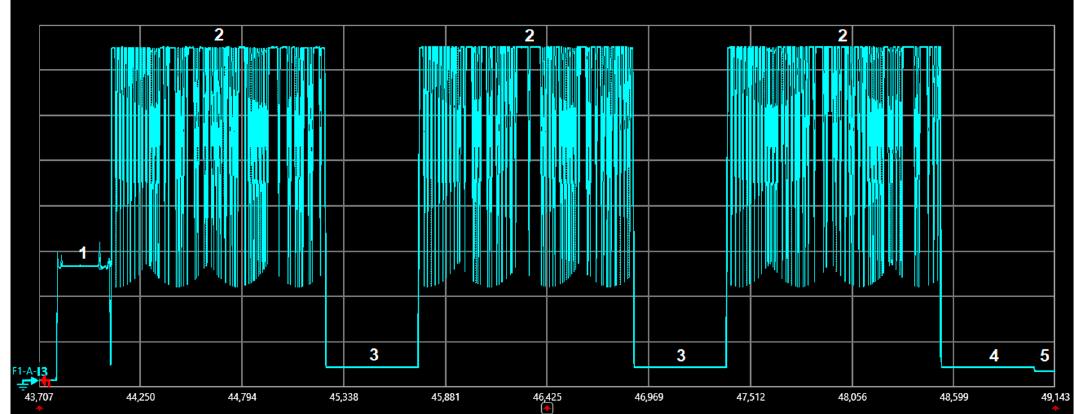
Figure 5. Current consumption profile of a MKRFOX1200 device performing a unidirectional transaction. The data message transmitted has a payload size of 1 byte. Table 2. States, variables and measurement results for Sigfox unidirectional transactions. For a bit